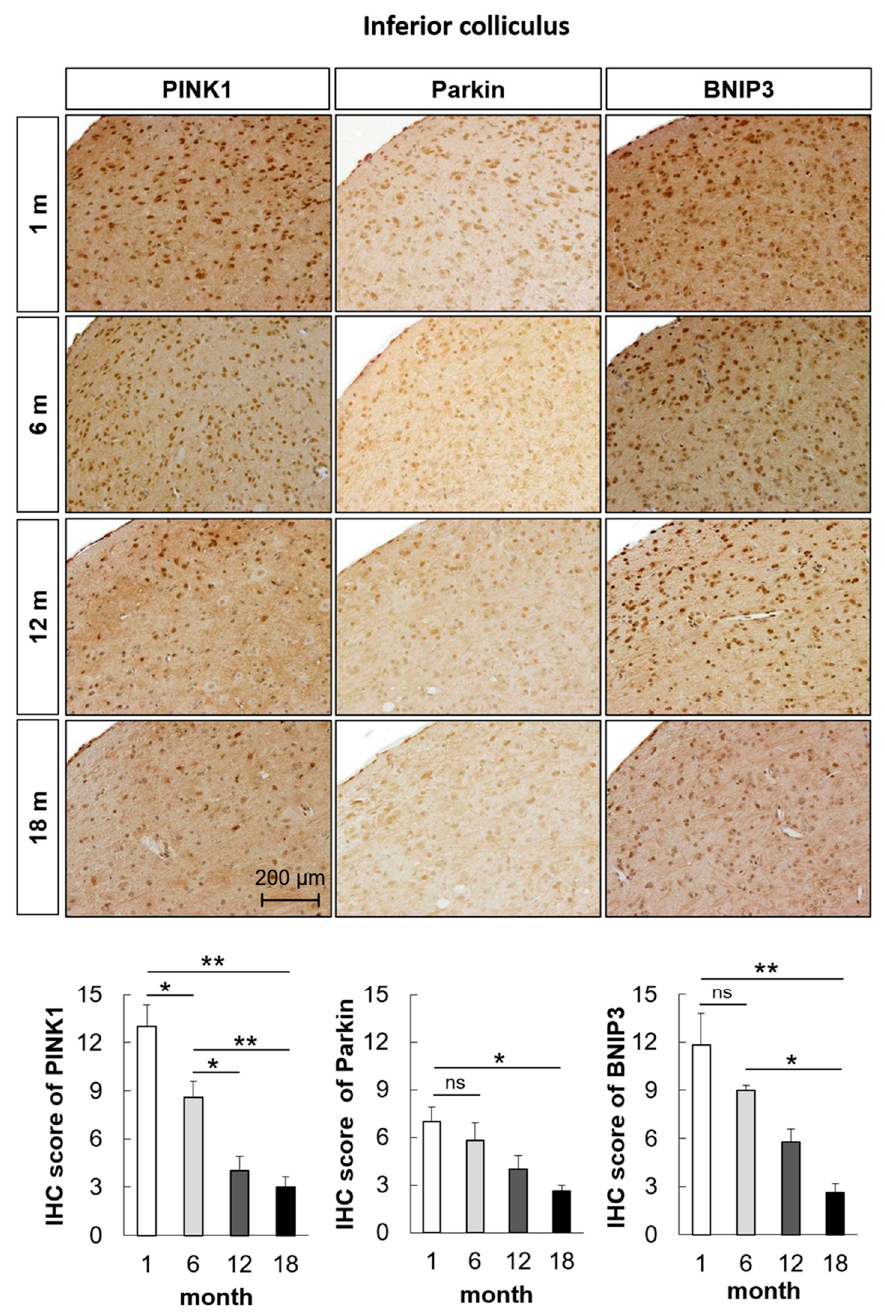
Figure 6. The protein expression levels of PINK1 , Parkin , and BNIP3 in the mouse inferior colliculus decrease with age. Immunohistochemical (IHC) scores of PINK1 , Parkin , and BNIP3 in the mouse inferior colliculus significantly decreased with aging. The data are shown as mean ± standard error of mean (five mice per group; 1 m, 1 month; 6 m, 6 months; 12 m, 12 months; 18 m, 18 months). * p < 0.05, ** p < 0.01, ns: not significant.